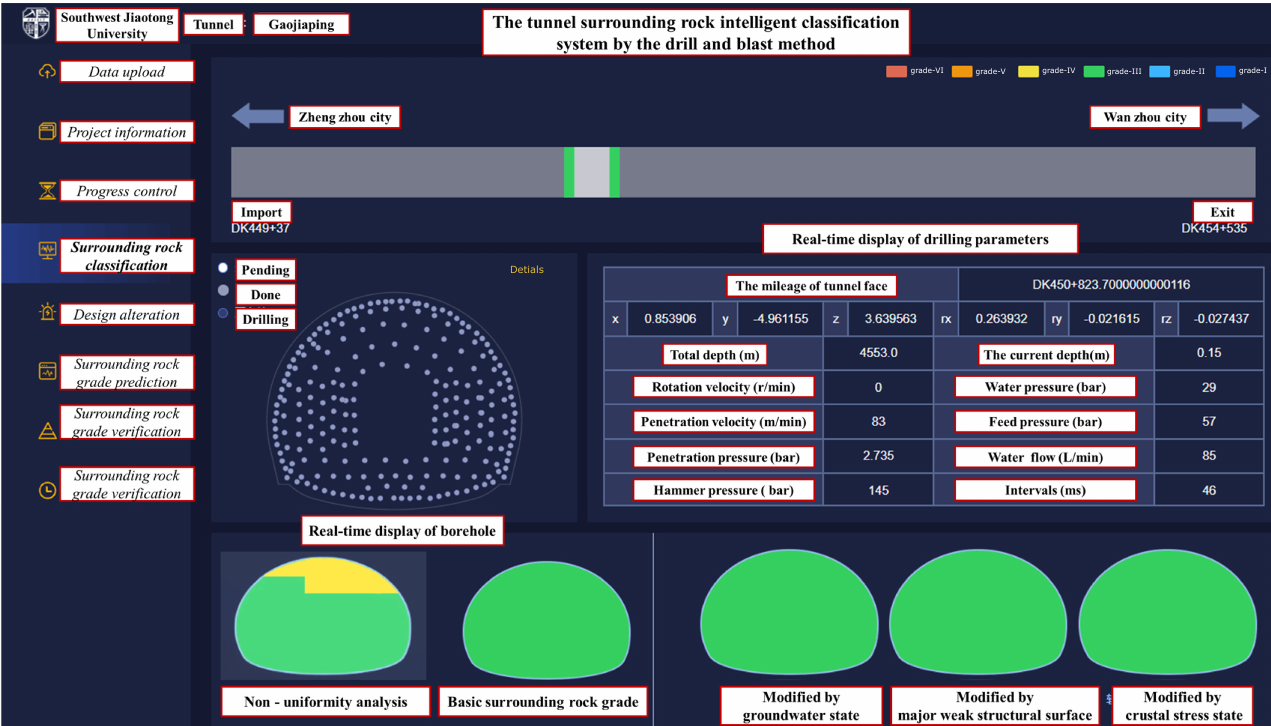
Figure 11. Interface of the ‘tunnel surrounding rock intelligent classification system by the drill and blast